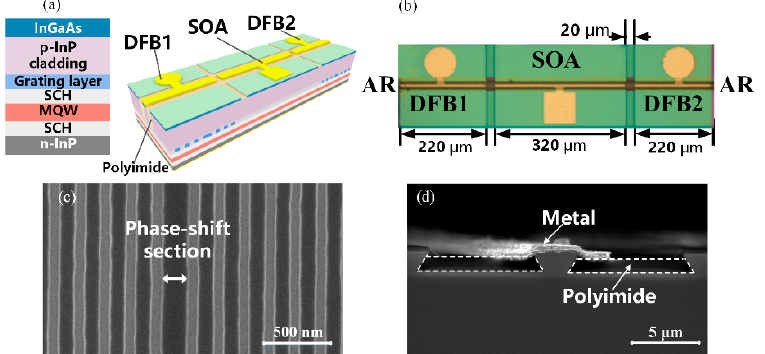
Figure 4. ( a ) Schematic and ( b ) optical photograph of the IMC laser. SEM of ( c ) the top view of the grating and ( d ) cross-section of the mesa.